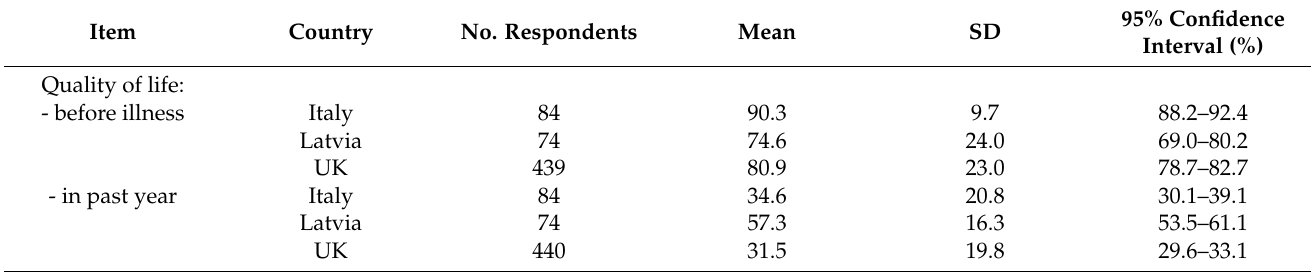
Table 8. Quality of